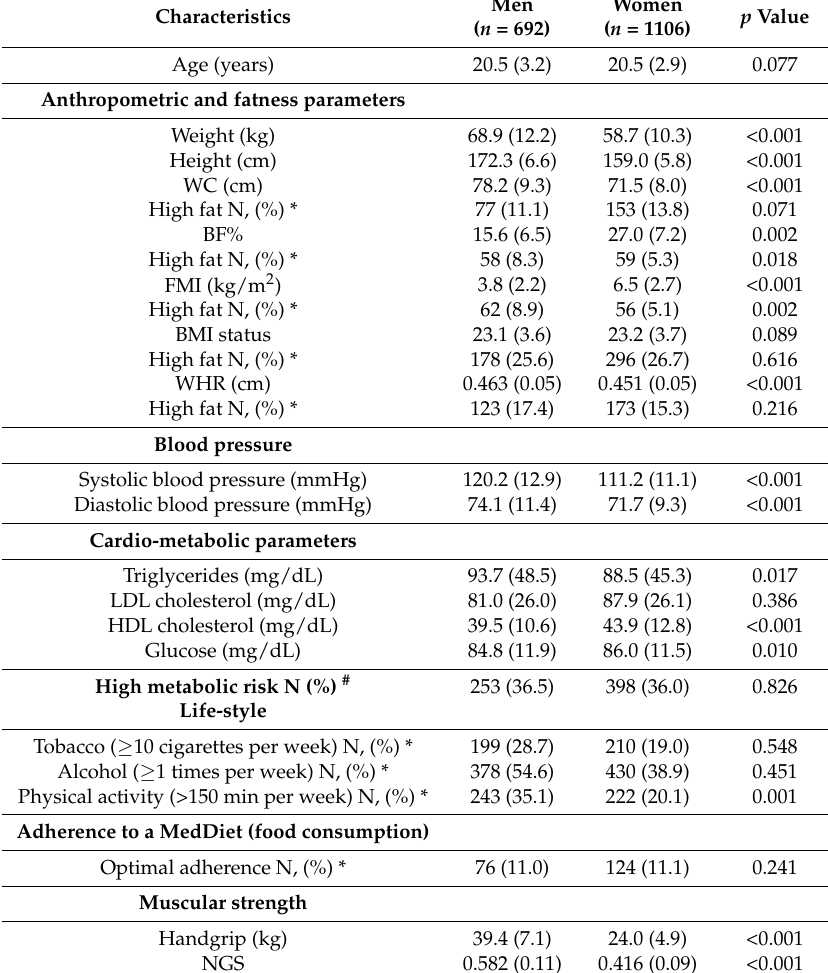
Table 1. Characteristics among a sample of college students from